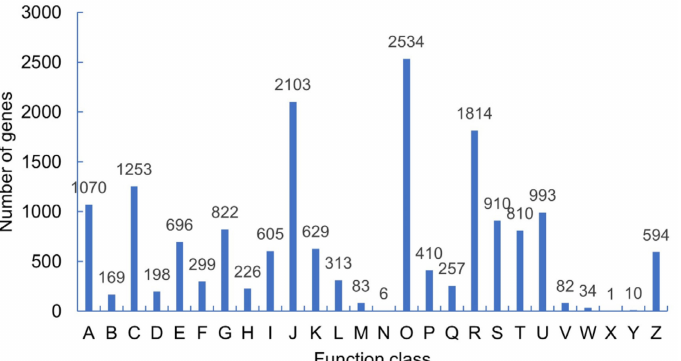
Figure 3. KOG classification of the DEGs. (A) Processing and modifying RNA; (B) chromosome structure and changes; (C) energy generation and transformation; (D) cell cycle regulation, division, and chromosome rearrangement; (E) amino acid transport and metabolism; (F) nucleotide trans- port and metabolism; (G) carbohydrate transport and metabolism; (H) coenzyme transport and metabolism; (I) lipid transport and metabolism; (J) translation, ribosome structure, and biosynthesis; (K) transcription; (L) replication, reorganization, and repair; (M) cell wall and membrane biosynthesis; (N) cell movement; (O) post translational modification, protein foldings and molecular chaperone; (P) inorganic ion transport and metabolism; (Q) synthesis, transportation, and metabolism of secondary metabolites; (R) general function prediction; (S) unknown function; (T) signal transduction mech- anism; (U) intracellular transport, secretion, and vesicular transport; (V) defense mechanism; (W) extracellular movement; (X) unnamed protein; (Y) nucleic acid structure; and (Z) cytoskeleton.